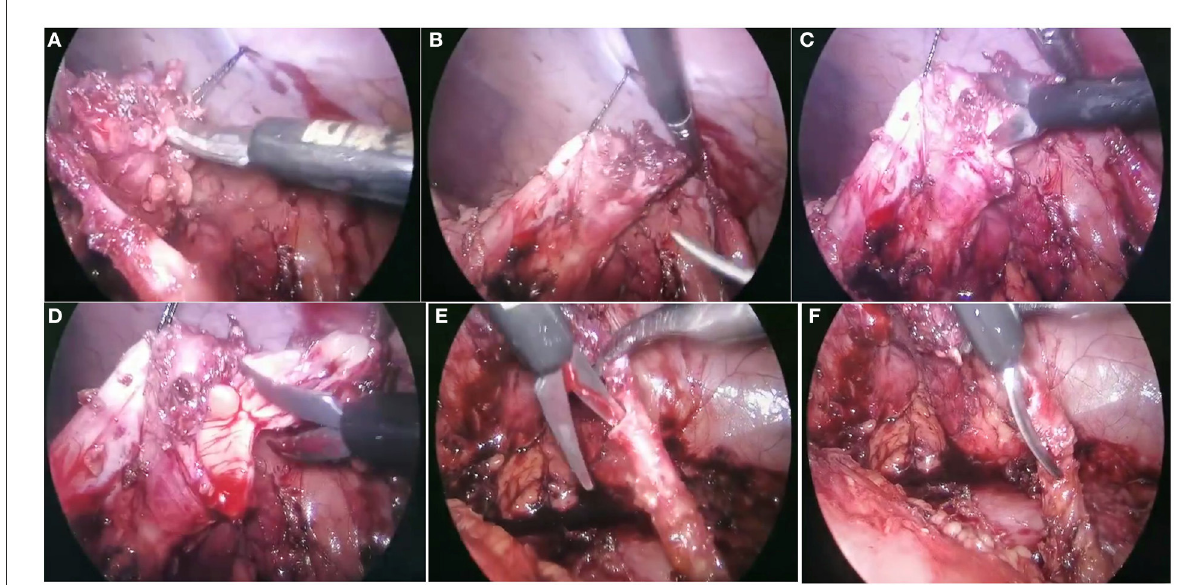
FIGURE1 Recurrent ureteropelvic junction obstruction (UPJO) patient treated with redo laparoscopic pyeloplasty (RLP). (A,B) Identified the reason for restenosis of the primary pyeloplasty was severe scar hyperplasia around the UPJ area (arrows). The normal ureter was then identified distally and dissection was carried out proximally toward the renal pelvis. (C,D) Refashioning the distended renal pelvis with excision of the redundant part. (E,F) Excised the fibrotic segment and excised the ureter laterally for about 1cm.